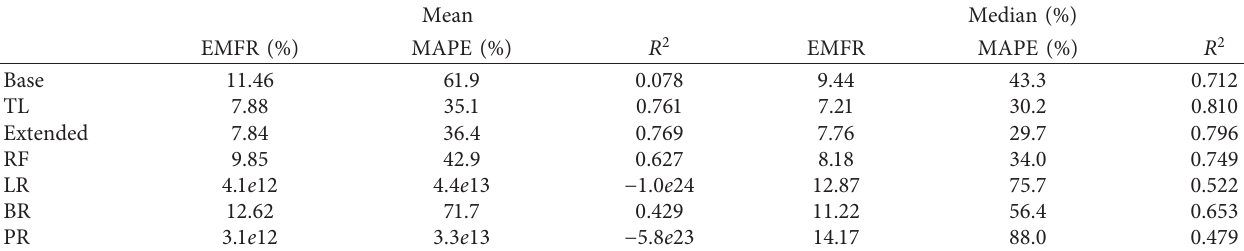
Figure 7: Median (a) R 2 , (b) MAPE, and (c) EMFR metrics depending on the size of the dataset. Table 5: The detailed results for different models—one week long training